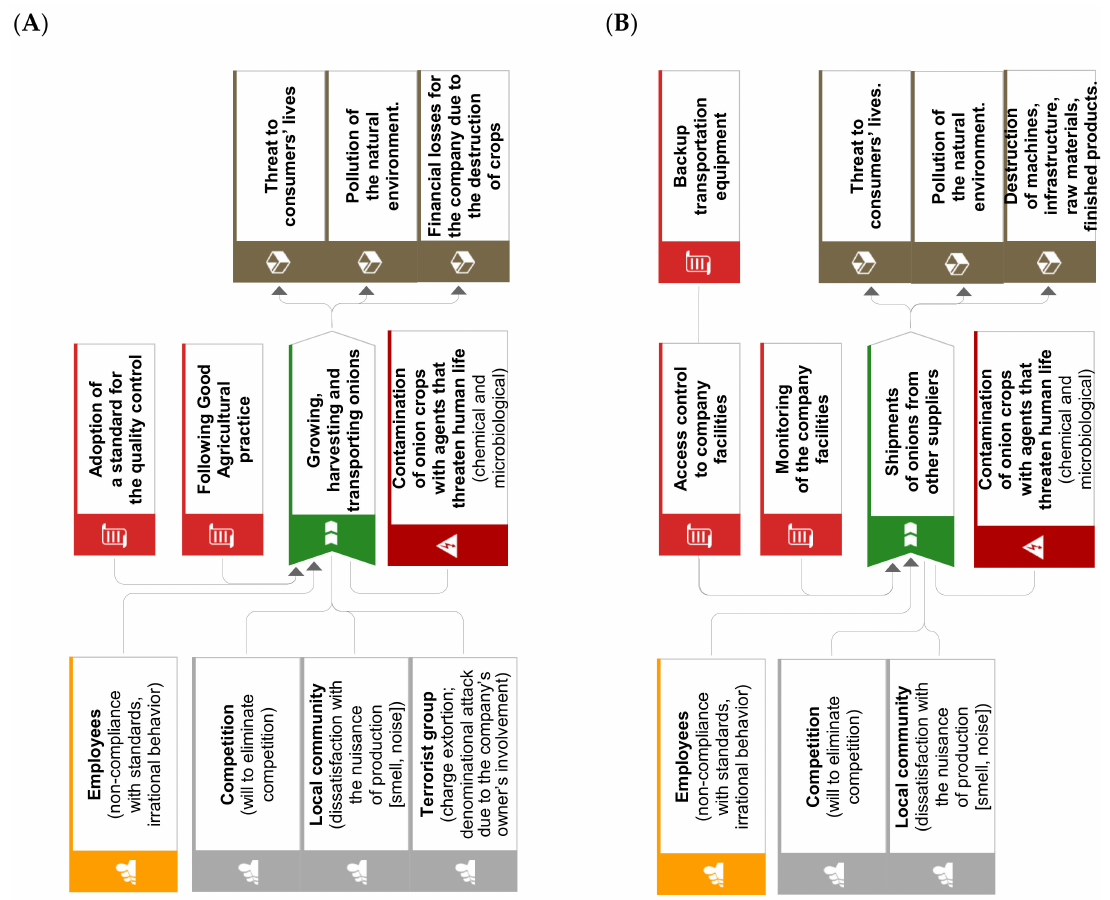
Figure 4. Selected hazards in the onion production process stages in the